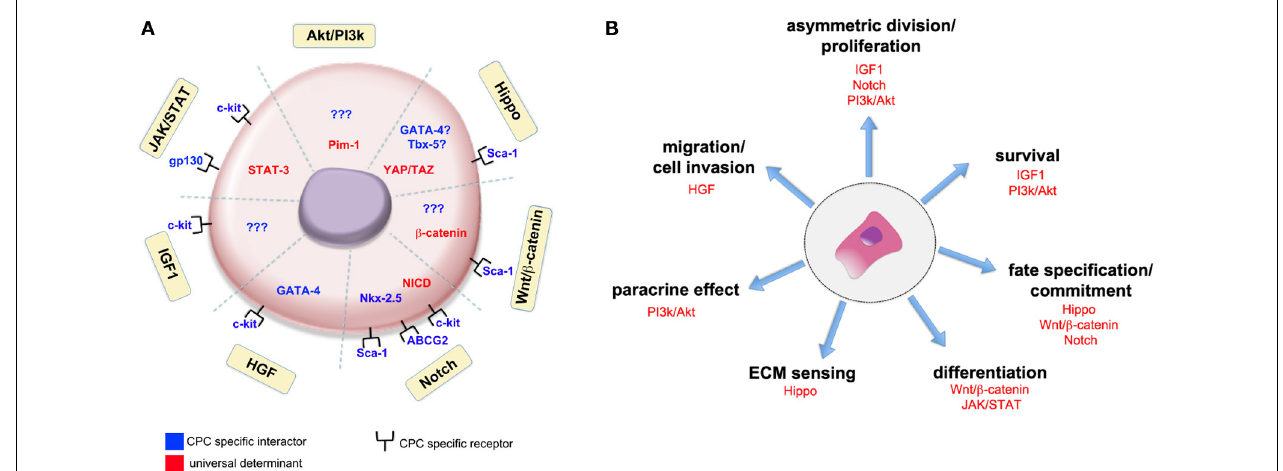
FIGURE 1 | Universal signaling pathways and cell-specific actuators interact in cardiac stem cells to induce given biological responses. The interaction of universal determinants (in red) and stage-specific actuators (in blue) in adult cardiac progenitor cells (CPCs) is schematically represented (A) . Yellow boxes identify the signaling pathways so far recognized to participate in CPCs function. The association with CPC